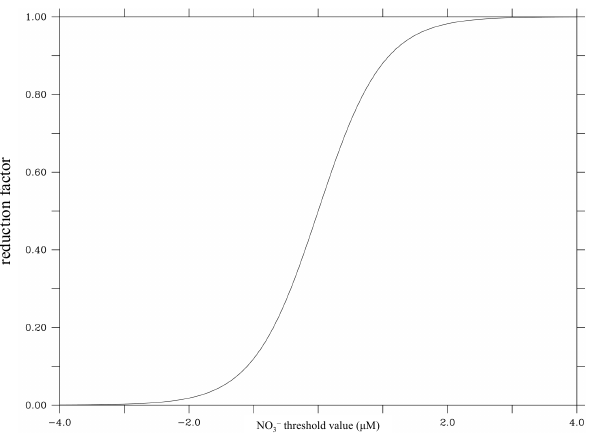
Fig. B1. Reduction factor applied to water column denitrification for given NO − concentration (µM) 3